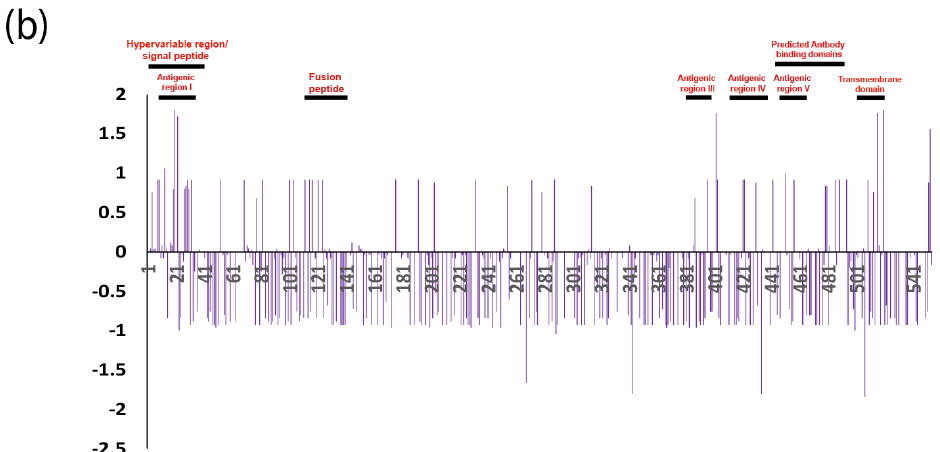
Figure 5. ( a ) Structure-based Antibody Prediction. X-axis contains the position of residues while the y-axis shows the propensity line indicates the threshold value. Regions above the threshold value, shown in green, are representing the residues under positive prediction. ( b ) The cumulative dN/dS of the average synonymous and non-synonymous substitutions moving codon by codon across F protein of AOAVv-1 isolates reported in Jordan including the reported isolates in this study with highlighting the most affected domains (high selective pressure) within the F protein.